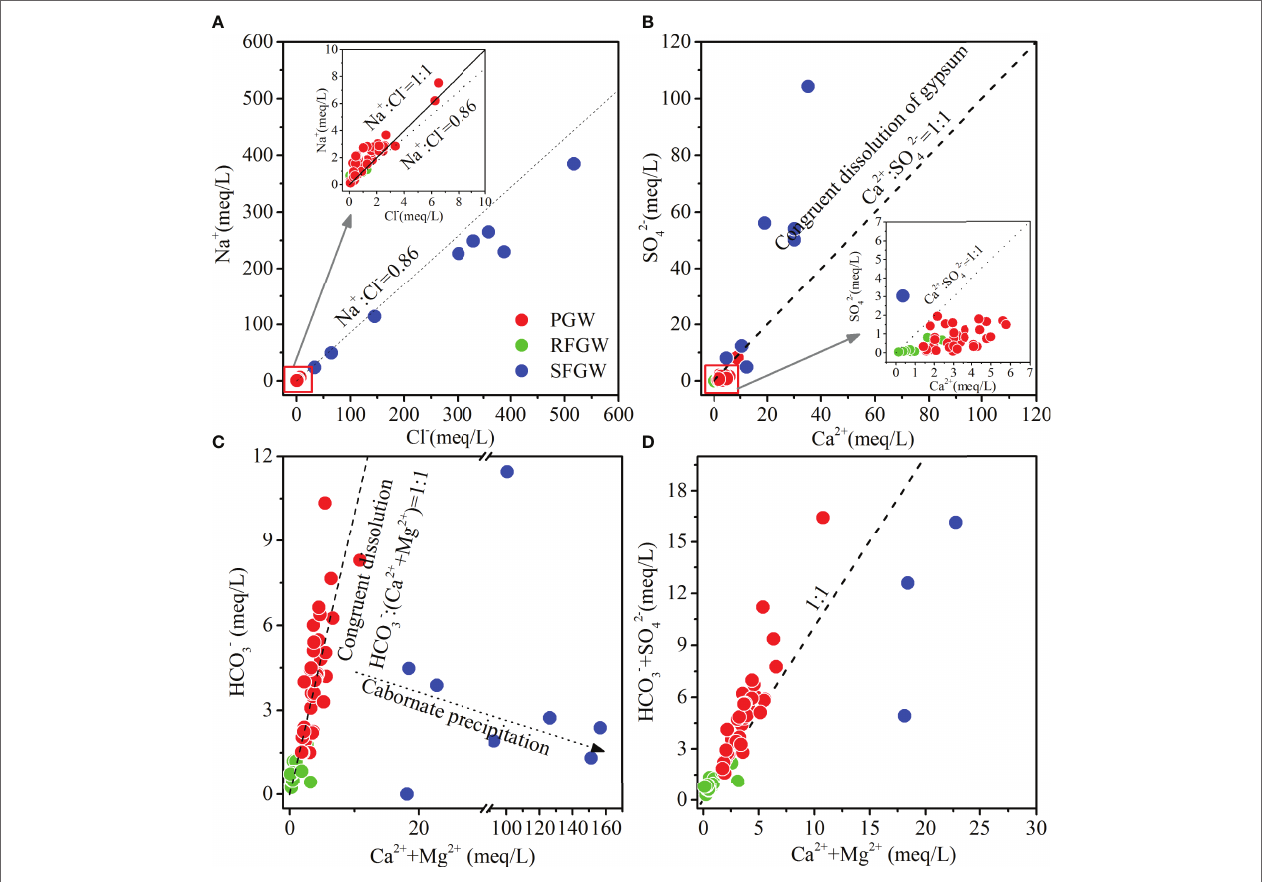
FIGURE 8 | Stoichiometric relation between Na + and Cl − (A) , SO 42− , and Ca 2+ (B) , Ca 2+ +Mg 2+ and HCO 3− (C) , and Ca 2+ +Mg 2+ and HCO 3− +SO 42− (D) .